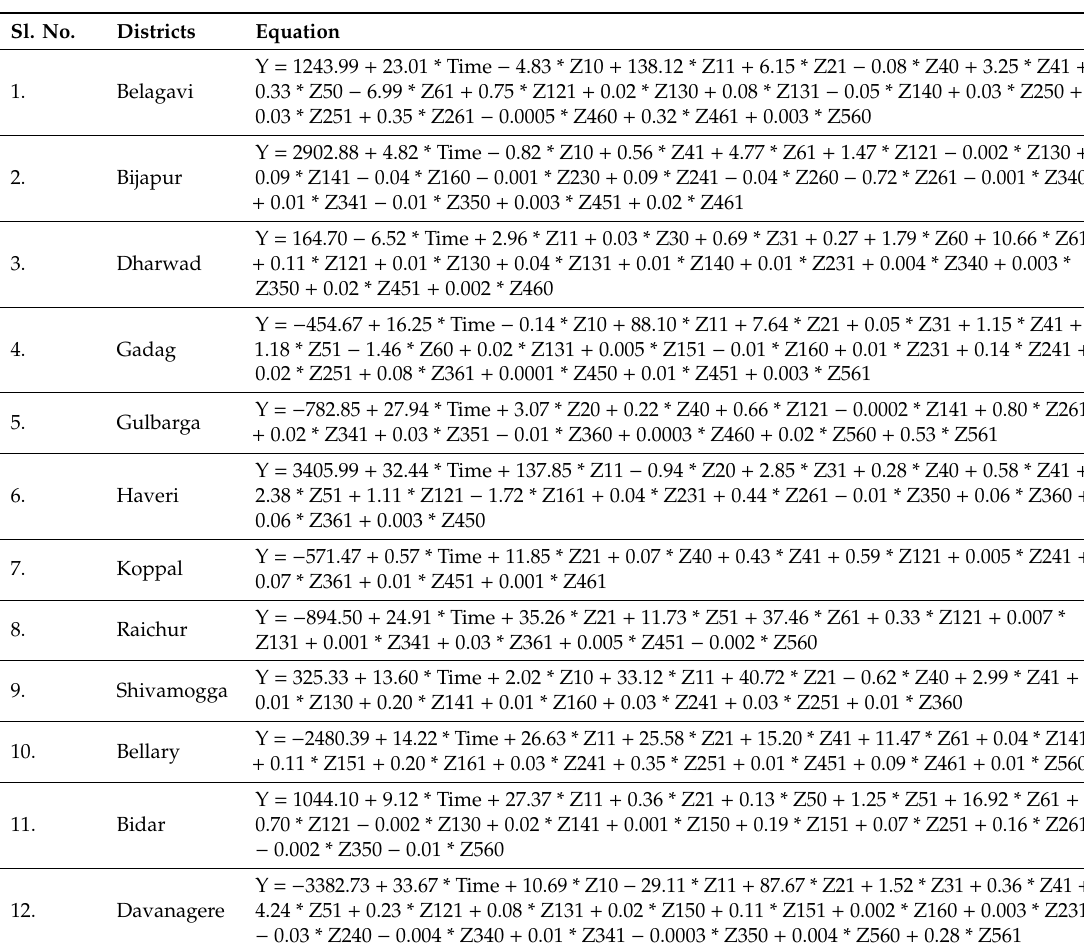
Table A4. Yield predicting equations derived from ENET for major sorghum growing districts of Karnataka including